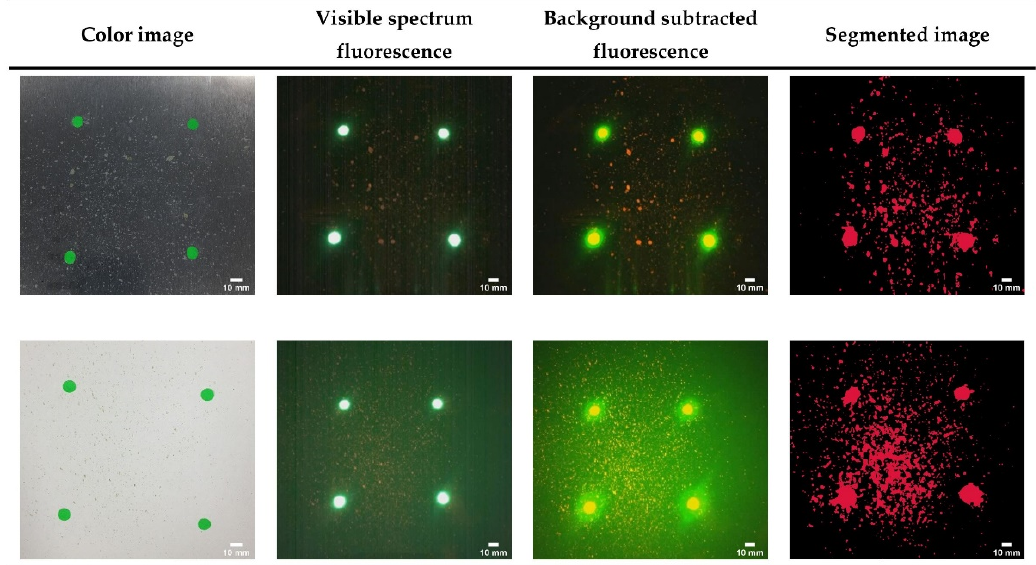
Figure 4. Images from the CSI-D system showing food residues (spinach) on stainless steel (top row) and plastic (bottom row) similar to those described in Figure 3, except the CSI-D RGB camera is used to capture visible light fluorescence instead of the CSI-D UV camera. In this series of images, the red band fluorescence is selected for adaptive thresholding to create the binary image segmentation mask. The scale bar for all images is set to 10 mm.